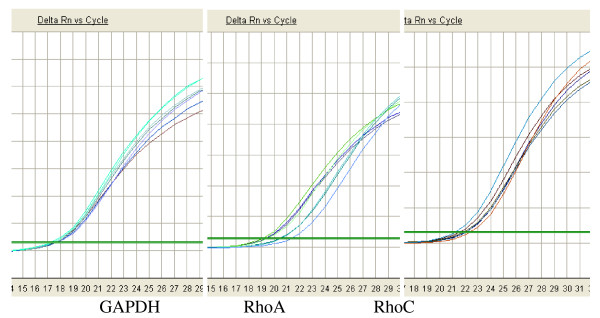
shows the amplification curve of GAPDH, RhoA and RhoC. They all exhibit standard S shape, suggesting a good amplification efficiency and linear relationship.